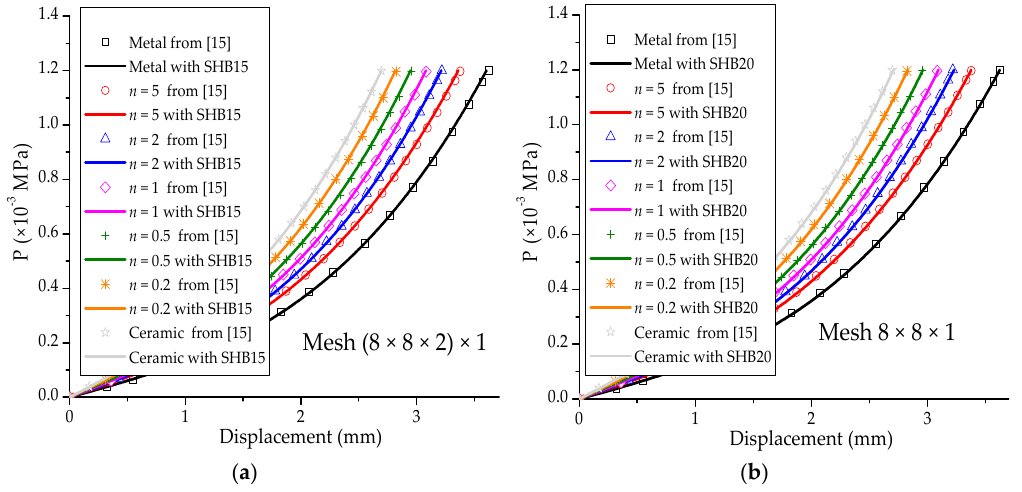
Figure 10. Load–deflection curves at the center point for the square plate. ( a ) Prismatic SHB15 element; ( b ) hexahedral SHB20 element.